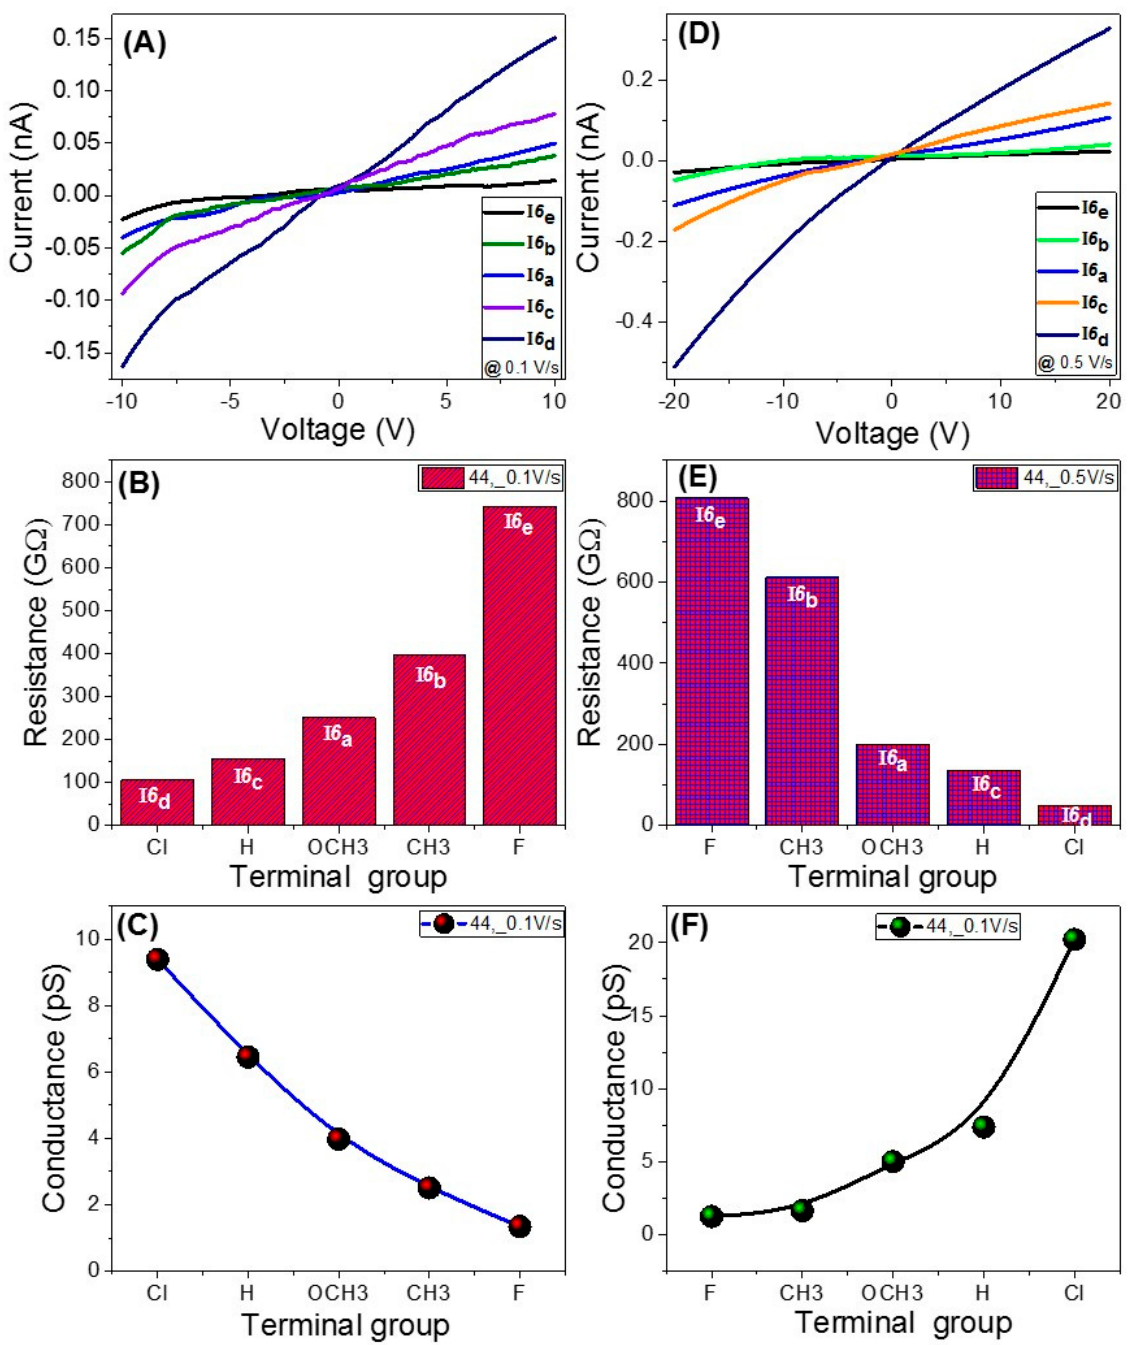
Figure 8. ( A , D ) Current-voltage characteristics, ( B , E ) variation of the electric resistance, and ( C , F ) variation of the electric conductance for the present series ( I6 a–e ) measured at scan rates 0.1 and 0.5 V/s at 115 °C.